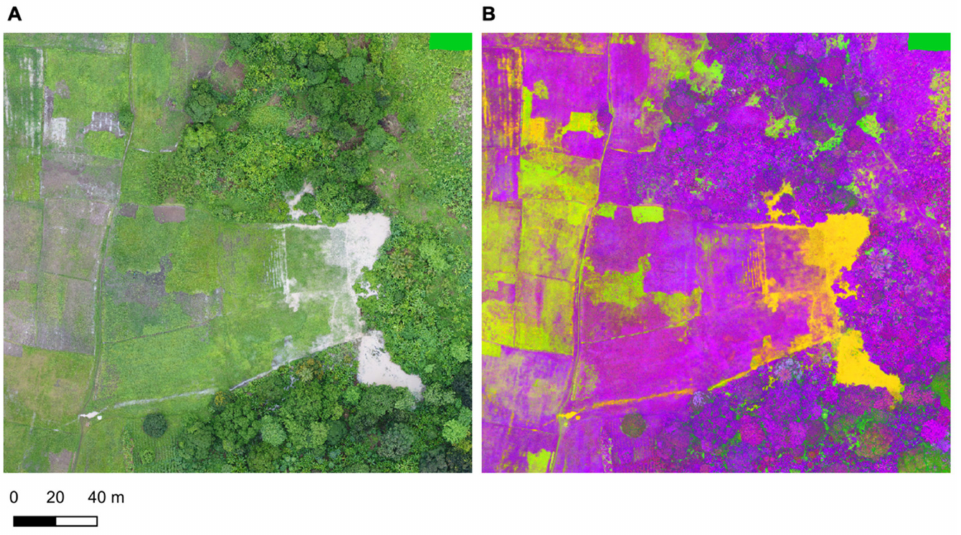
Figure 4. Example conversion of ( A ) RGB drone imagery into ( B ) the LAB colour space at Upenja. Once the image is converted to a LAB colour space, the operator can begin the digitiz- ing process. The user selects a point within the image that he/she believes is a potential breeding site (Figure 5). A window is then formed around this point, the size of which can be adapted by the user. All the pixels in this window are plotted in the LAB colour space, and their Euclidean distance (within this feature space) to the selected point are calculated. A threshold (can be adapted by the user) is then used to determine whether a pixel within the window is sufficiently similar to the selected point. If it is deemed to be similar, it is added to the region. To ensure complete coverage of the image, a 100 × 100 m grid is generated over the input image by the RegionGrow tool to help guide the operator, i.e., the operator interrogates each grid square and digitizes any potential larval habitats found.